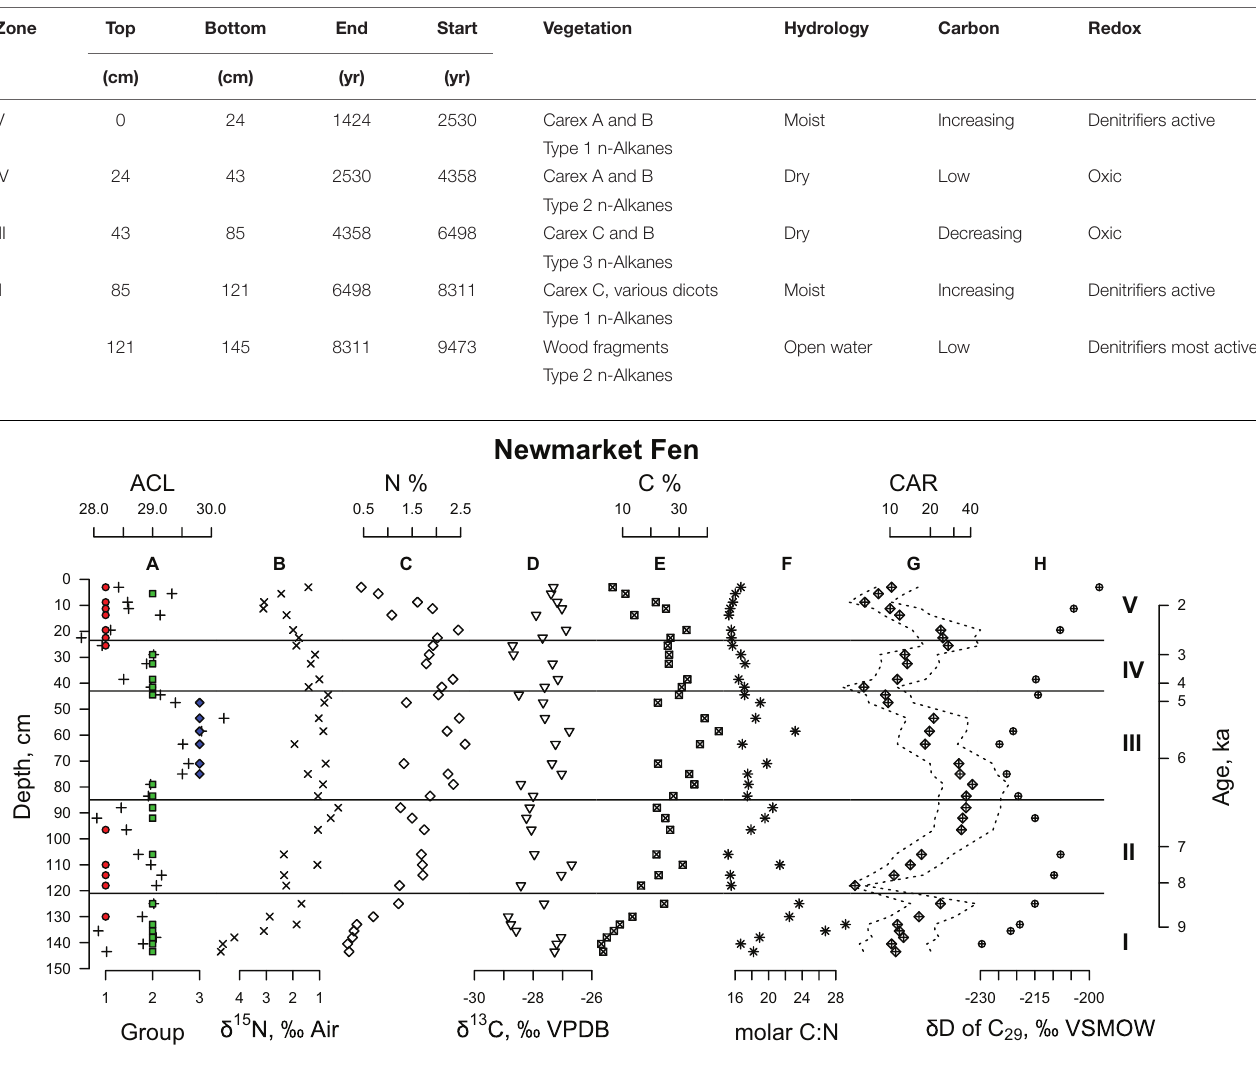
FIGURE 4 | Geochemical data from Newmarket Fen sediments: (A) n-Alkane distributions displayed by Type (as in Figure 3 ) and Average Chain Length (plus sign symbols); (B) Nitrogen Isotope ratios in per mille vs. air; (C) Percent nitrogen by weight; (D) Carbon isotope ratios in per mille vs. VPDB; (E) Percent carbon by weight; (F) Molar carbon to nitrogen ratio; (G) Carbon accumulation rate in grams carbon per meter squared per year, with 75% confidence intervals propagated from the Bacon age-depth model; (H) Hydrogen isotope ratios of C 29 n -alkane in per mille VSMOW. Horizontal lines indicate macrofossil zones (as in Figure 2 ).